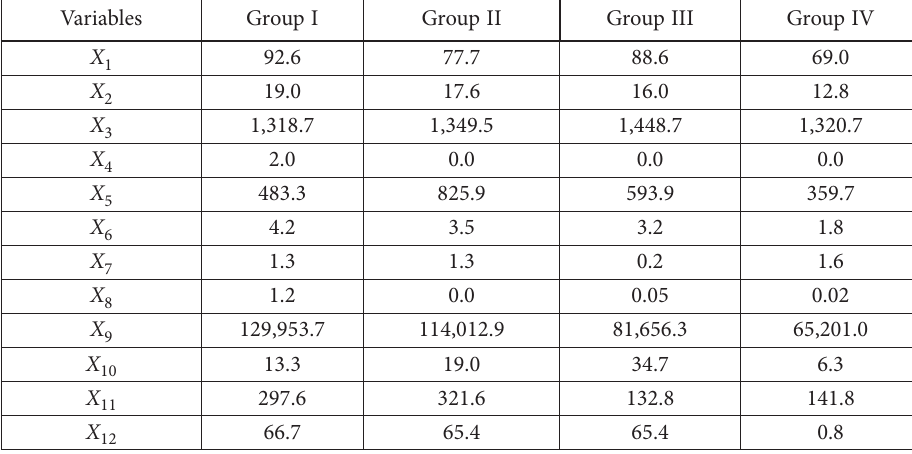
Table 6. Average values of variables describing the level of socio–economic development